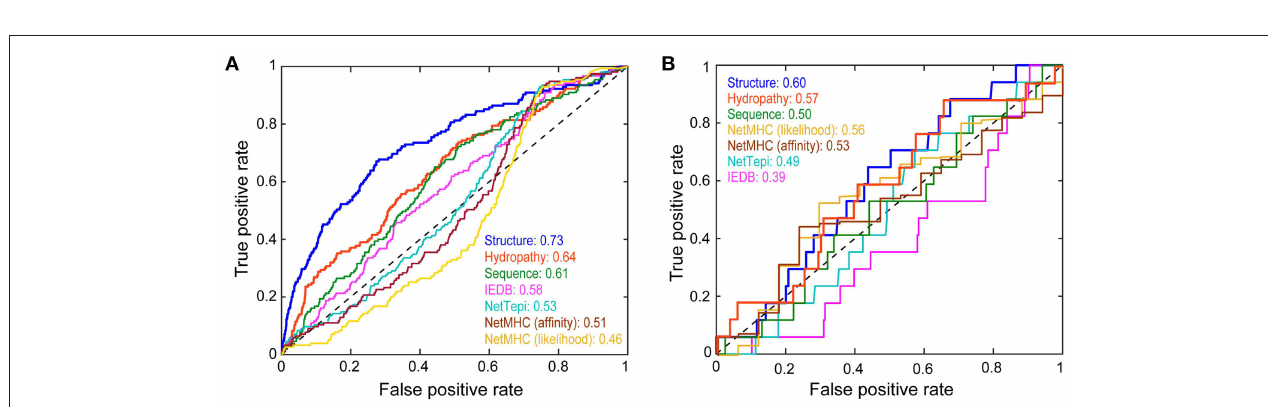
FIGURE 5 | Performance of the structure-based neural network in categorizing peptide immunogenicity. (A) Performance of the structure-based neural network compared to control sequence-only and hydropathy-only neural networks, the IEDB and NetTepi immunogenicity prediction servers, and NetMHCpan 4.0 in evaluating the training data as demonstrated by a receiver operating characteristic curve. The area under the curve (AUC) for each approach gives the probability that the approach will more favorably score an immunogenic peptide than a non-immunogenic peptide. The structure-based neural network performed the best. (B) Against a neoantigen dataset of 291 nonameric peptides not used for training the structure-based network performed less favorably but still outperformed the other